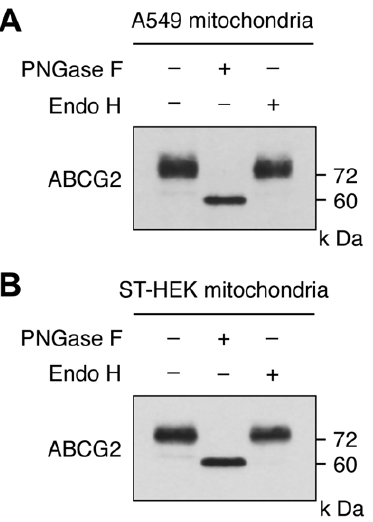
Figure 10. Characterization of protein N -glycosylation occur- ring on mitochondrial ABCG2 of A549 cells and ST-HEK cells. Mitochondrial preparations of A549 cells (A) and ST-HEK cells (B) were treated with PNGase F or Endo H, and then ABCG2 was detected by Western blotting using a polyclonal anti-ABCG2 antibody. A represen- tative blot of three independent experiments is